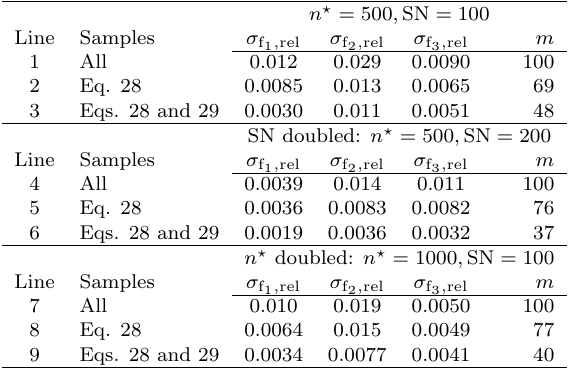
TABLE 5 Mean of relative errors σ , σ and σ for one f 1 , rel f 2 , rel f 3 , rel hundred model 18 simulations with n (cid:63) = 500 and SN=100. Lines 1-3 give results for all models ( m = 100) , when Eq. 28 criterion models are removed ( m = 100 → 69) , and when Eq. 29 criterion models are also removed ( m = 69 → 48) . Signal to noise ratio SN is doubled on next three